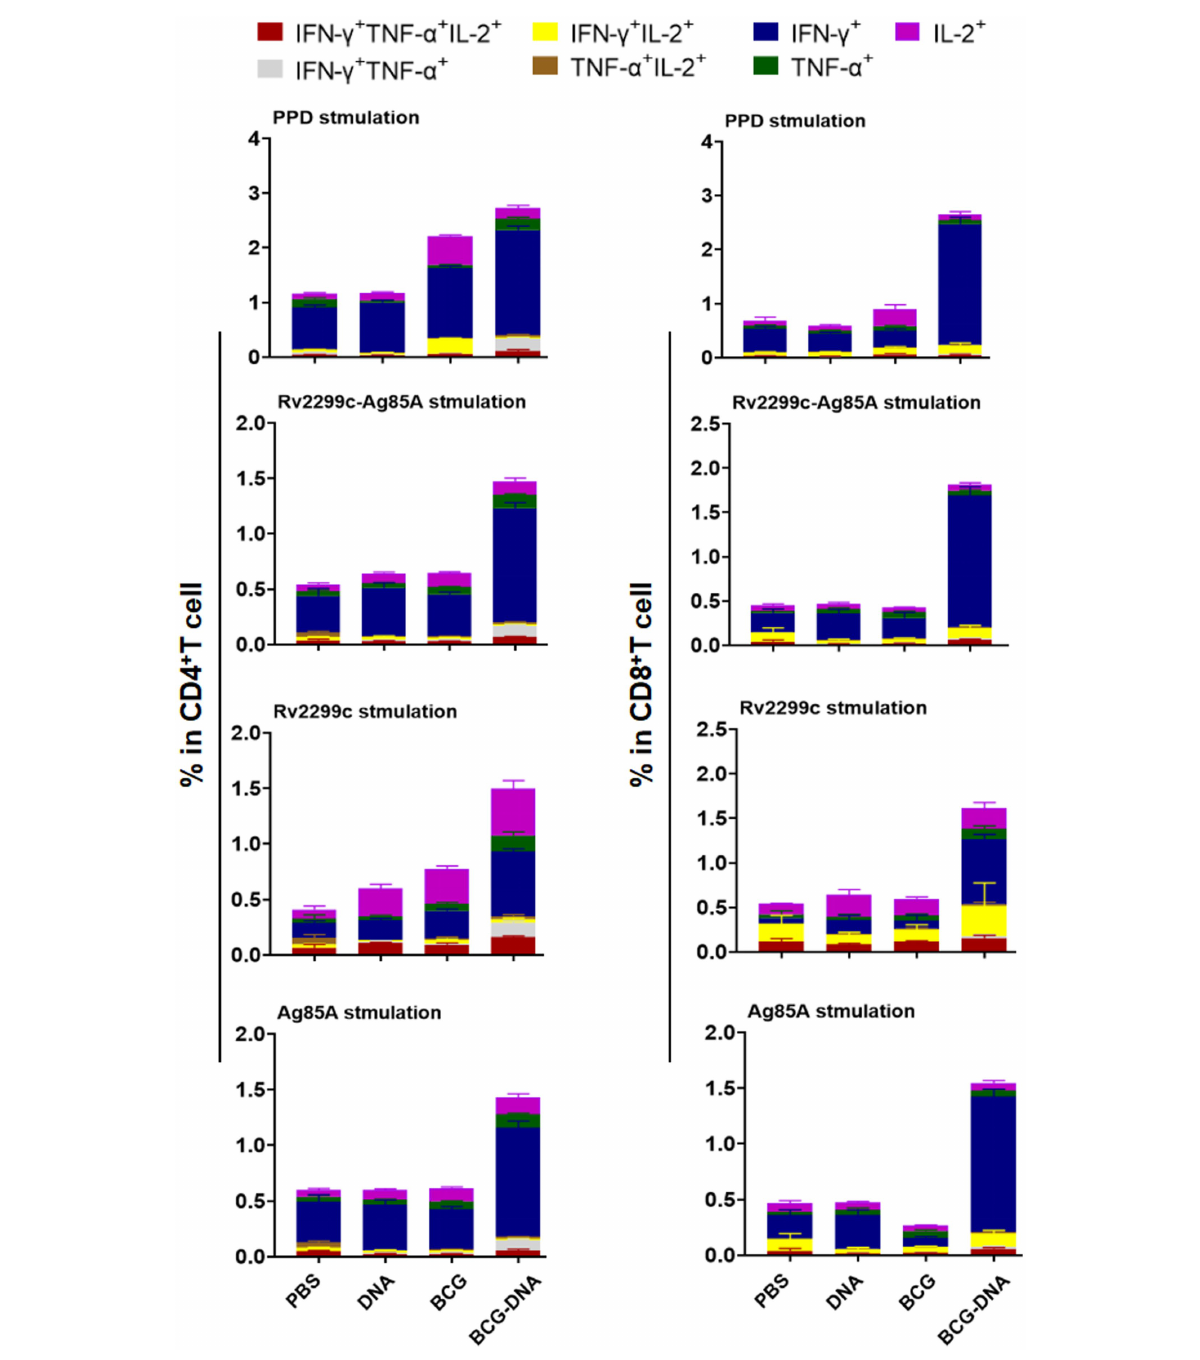
FIGURE 6 Polyfunctional CD4 + and CD8 + T-cell populations in the lungs of immunized mice after H37Rv challenge. Four weeks after infection of immunized mice pulmonary lymphocytes were collected and stimulated ex vivo with PPD, Ag85A or Rv2299c or Rv2299c-Ag85A. Frequencies of antigen- specific CD4 + (left) and CD8 + (right) T cells producing single or multiple cytokines were analyzed by flow cytometry. ( n = 5 mice, mean ±